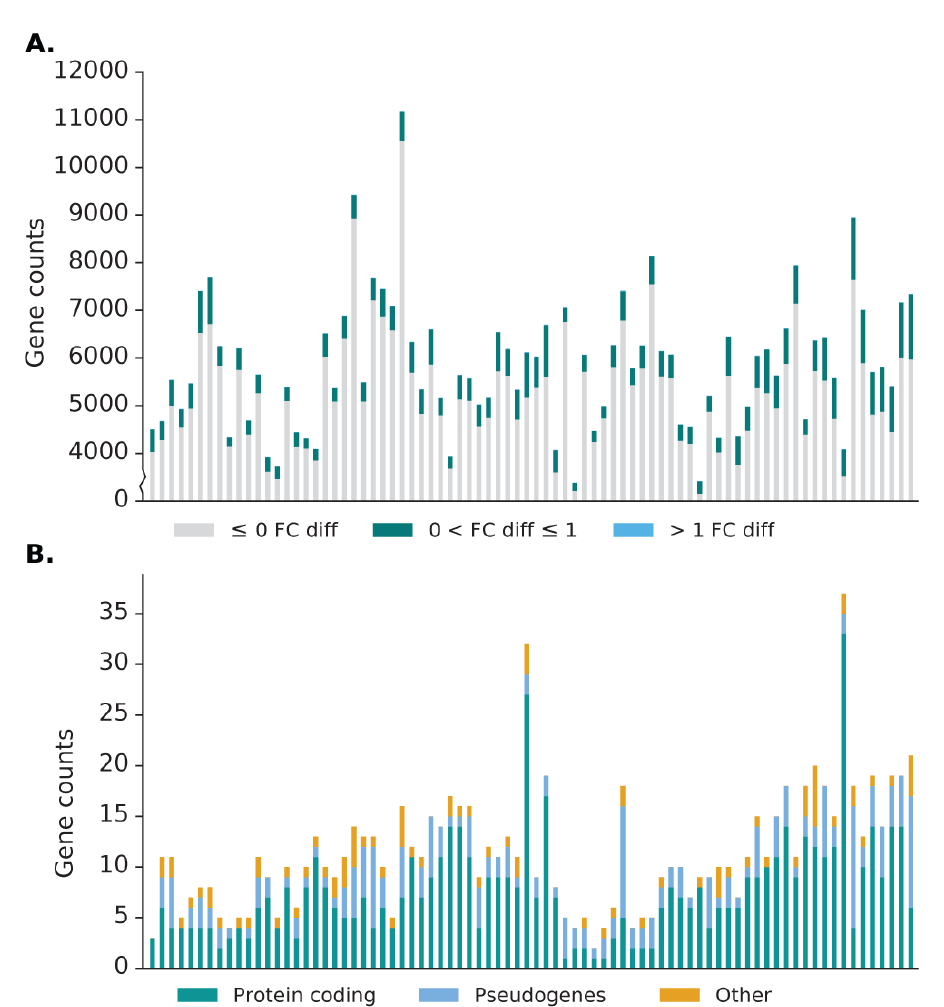
Figure 7. Effect of Scavenger read recovery on gene expression for single-cell RNA-seq datasets. A . The number of genes whose reads are recovered by Scavenger, categorised based on the fold change in normalised expression (RPM) between source alignment and after Scavenger recovery. B . The number of genes with more than 1 fold change in normalised expression categorised based on their gene